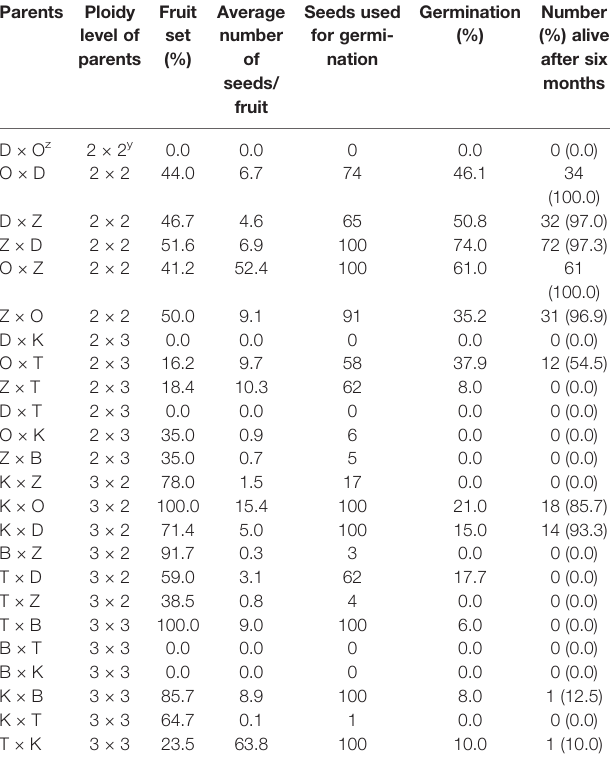
TABLE 3 | Percent fruit set, average number of seeds/fruit, seeds used for germination, germination rate, and six-month seedling survival of progenies resulting from interploidy and intraploidy crosses of Hydrangea macrophylla .